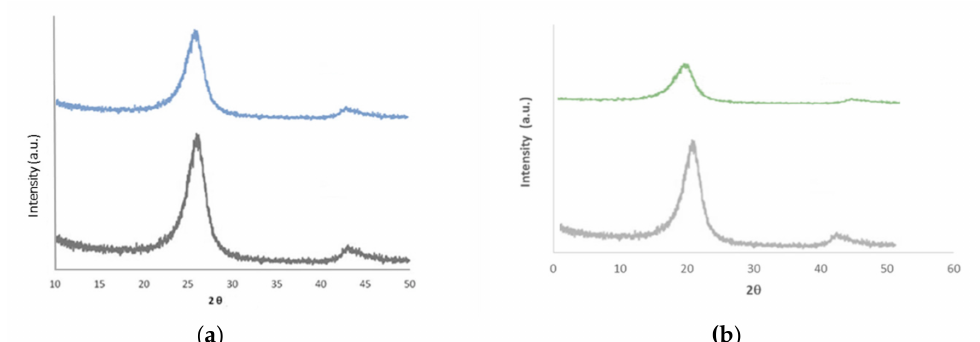
Figure 1. Powder X-ray diffraction (XRD patterns of ( a ) the initial supports Norit (lower) and graphene (upper), and ( b ) supported Re NPs in Norit (Re/C—lower) and graphene